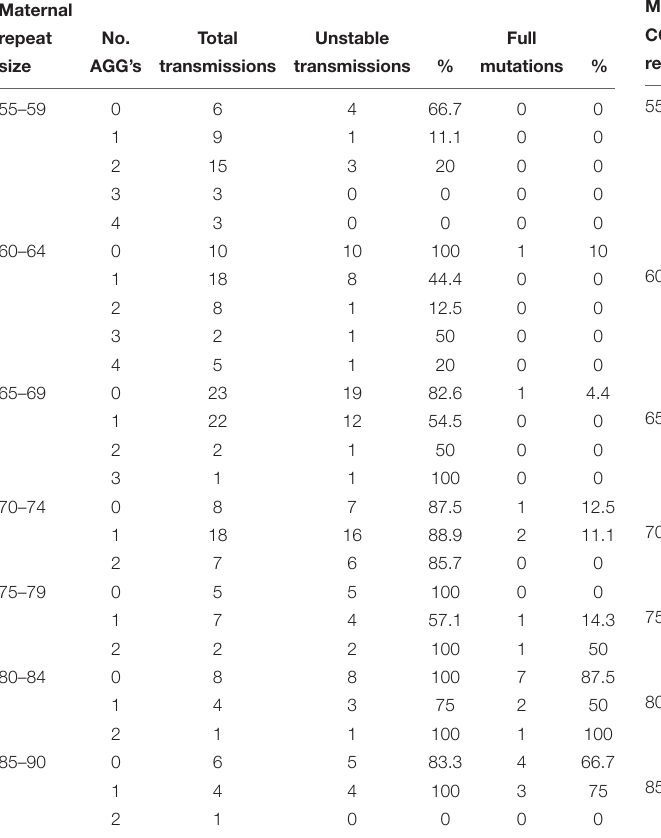
TABLE 4 | Unstable transmissions and full mutation expansions sorted by repeat size and number of AGGs based on the combined Israeli and international data.